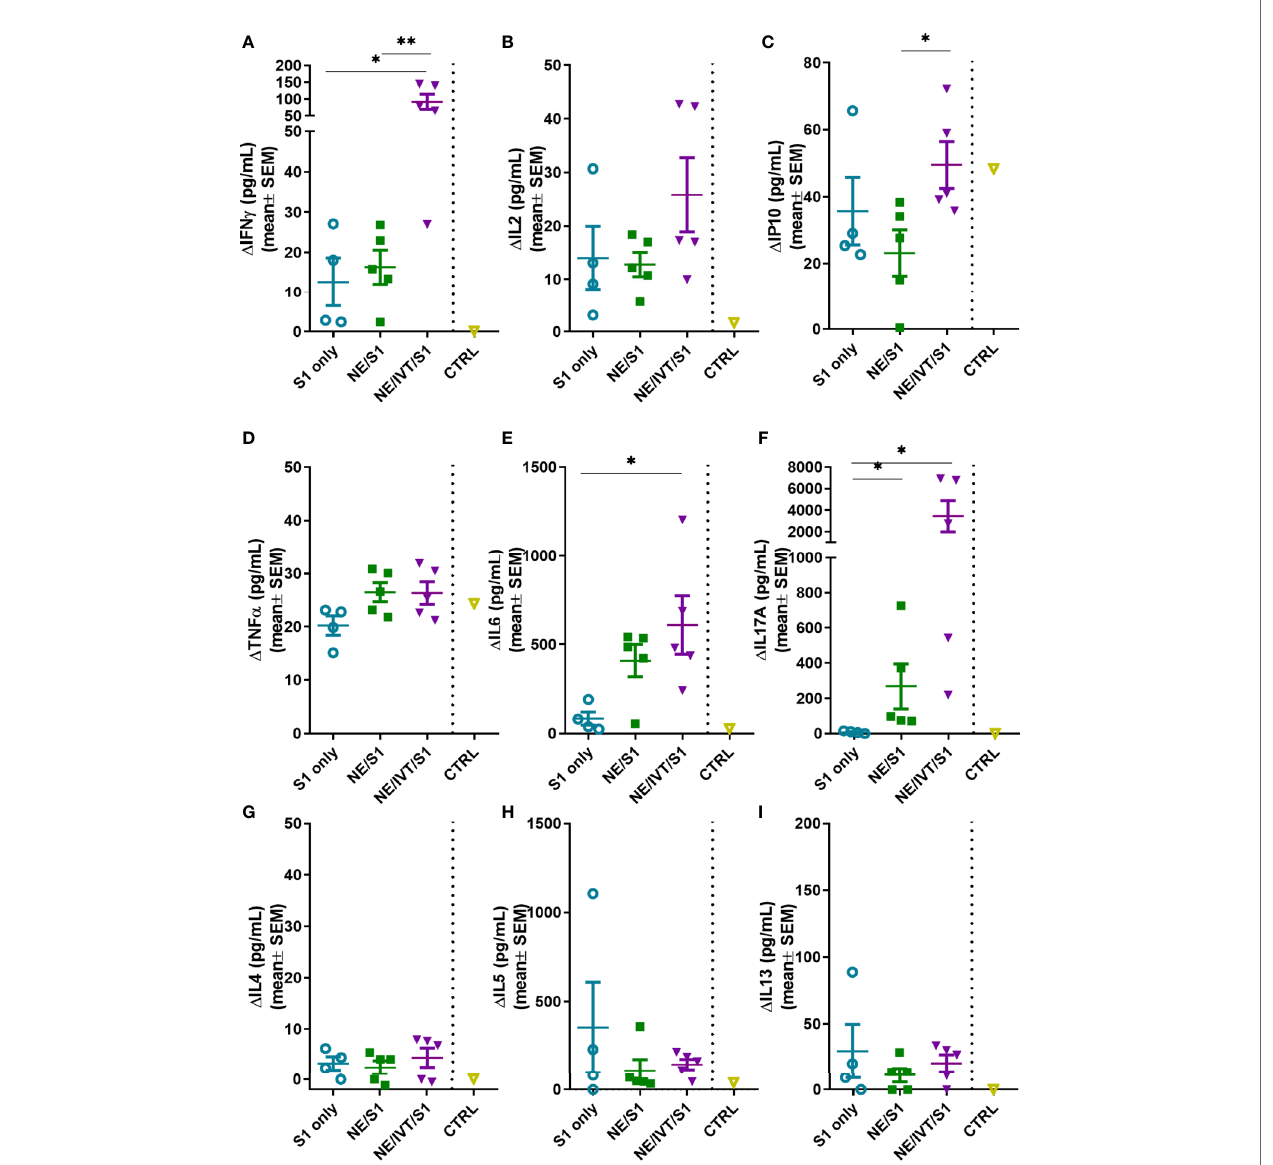
FIGURE 6 | Antigen recall response assessed in splenocytes from immunized animals. Splenocytes isolated from mice immunized IN with S1 alone, or with NE, or NE/IVT after the fi nal boost immunization (10 weeks post-initial immunization) were stimulated ex vivo with 5 m g of recombinant S1 for 72 h, and levels of secreted cytokines (A) IFN g , (B) IL2, (C) IP10, (D) TNF a , (E) IL6, (F) IL17A, (G) IL4, (H) IL5, (I) IL13 were measured in the supernatant relative to unstimulated cells by multiplex immunoassay. An unvaccinated control was included for comparison. ( n = 5/grp; *p < 0.05, **p < 0.01 by Mann-Whitney U